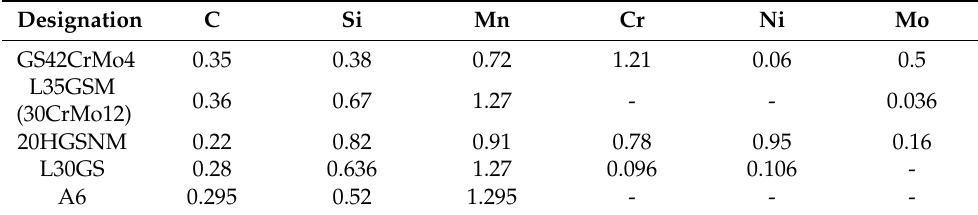
Table 2. Chemical composition of cast steel (mass%).